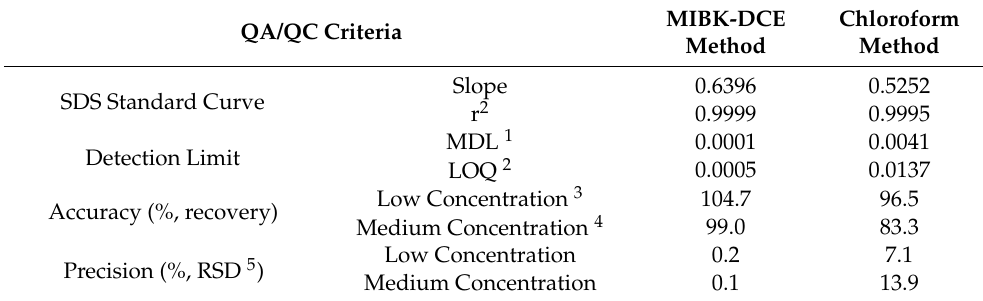
Table 8. QA/QC data by MIBK-DCE method and chloroform method.